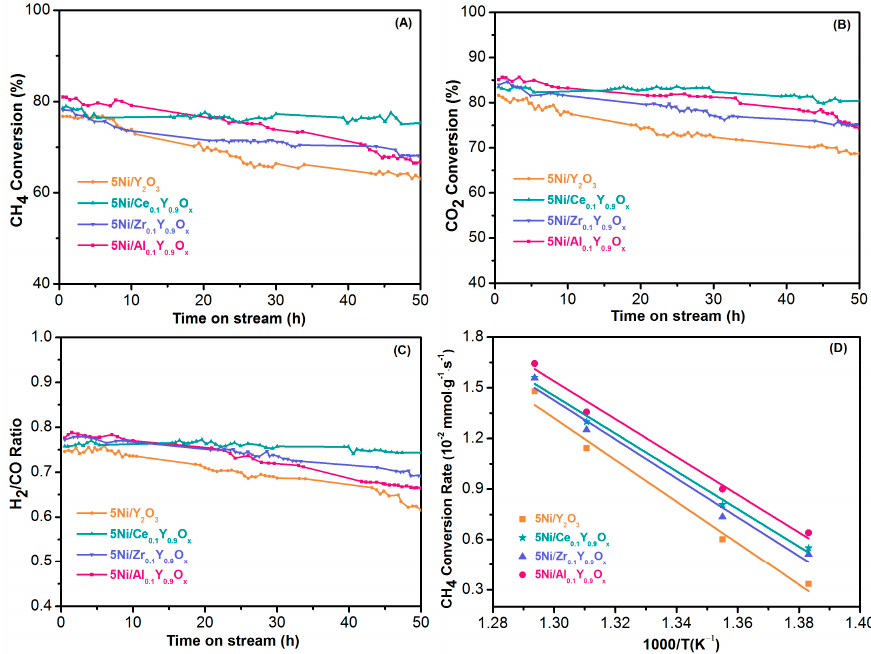
Figure 3. Stability evaluation of the catalysts at 750 °C: ( A ) CH 4 conversion, ( B ) CO 2 conversion, ( C ) H 2 /CO Ratio, and ( D ) Arrhenius plots for DRM. Table 1. DRM kinetics results of the catalysts.